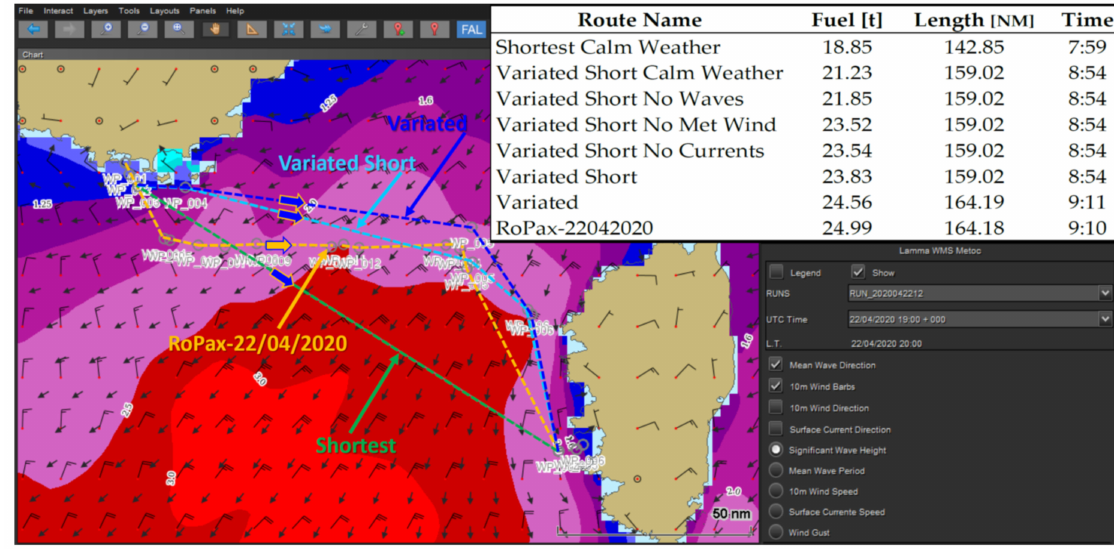
Figure 9. Visualization, through the prototype interface, of the SWH field map, together with Mean Wave Direction vectors and Wind Barbs. The superimposed bold yellow and blue arrows mark the position of the ship along the four studied routes. The “Routes sorting” table at top right shows the respective fuel consumption in tonnes. For some of them, the estimates obtained by skipping one by one and all the metocen contributions to resistance are also shown. The Time column shows voyage duration in hours and minutes (h: